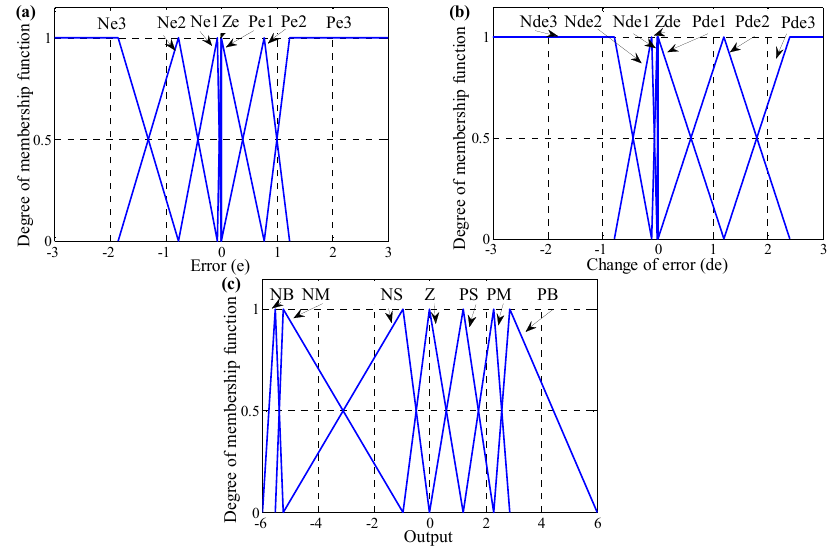
Figure 15. Performance comparison based on QLSAF, LSAF, BSAF, GSAF and PSOF. QLSA ‐ based FLC: QLSAF; LSA ‐ based FLC: LSAF, BSA ‐ based FLC: BSAF, GSA ‐ based FLC: GSAF, PSO ‐ based FLC: PSOF.